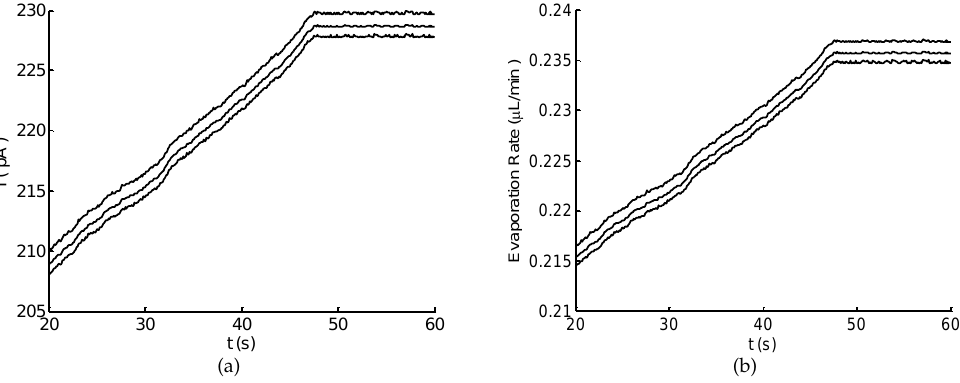
Figure 7. Measurement results of the detected current ( a ); and the corresponding evaporation rate ( b